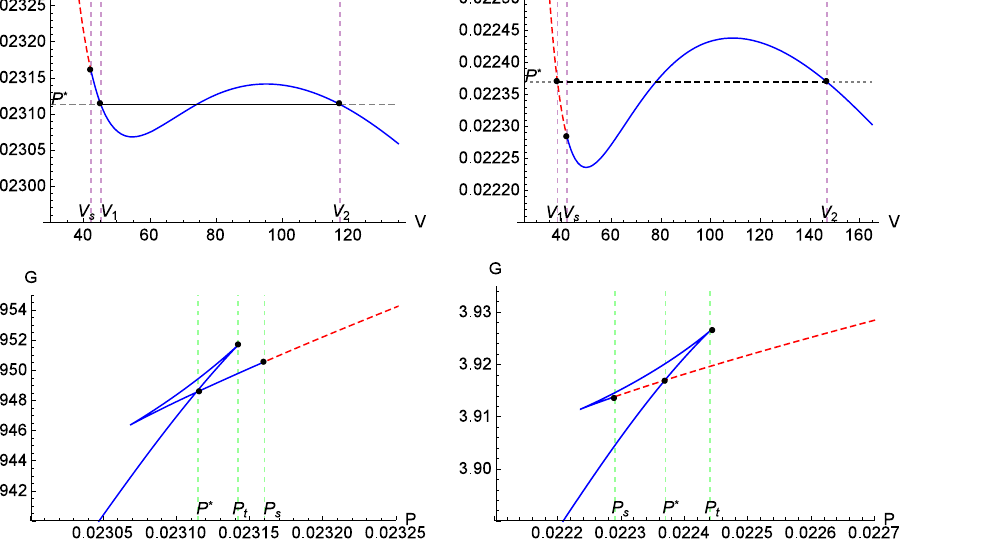
r 2 = 2 . 20835, respectively. Note that r 1 > r s . Right The temperature takes the value of T = 0 . 13800. For the isobar P ∗ = 0 . 02237, V s , V 1 , and V 2 correspond to r s = 1 . 70998, r 1 = 1 . 66931, and r 2 = 2 . 33574, respectively. Note that r 1 < r